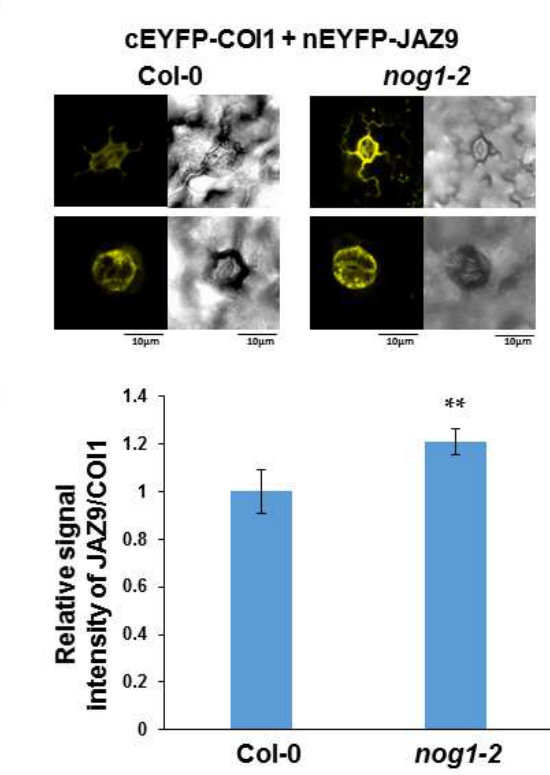
Figure 4. NOG1-2 may alter the interaction of JAZ9 with COI1. (A) BiFC in Arabidopsis was examined to test the interaction between JAZ9 and COI1. Seedlings were treated with COR (20 nM) and samples were collected after three hours for microscopy. JAZ9 fused to the N-terminal half of the EYFP was co-expressed with COI1 fused to the C-terminal half of EYFP in Col-0 or nog1-2 . Reconstitution of the yellow fluorescence was observed in the guard cells of stomata. (B) Relative signal intensities of the yellow fluorescence in the guard cells of Col-0 and the nog1-2 mutant were quantified. Bars represent means ± standard deviation; ** p < 0.01 (Student’s t -test). Five seedlings were used for each experiment and the experiment was repeated three times.